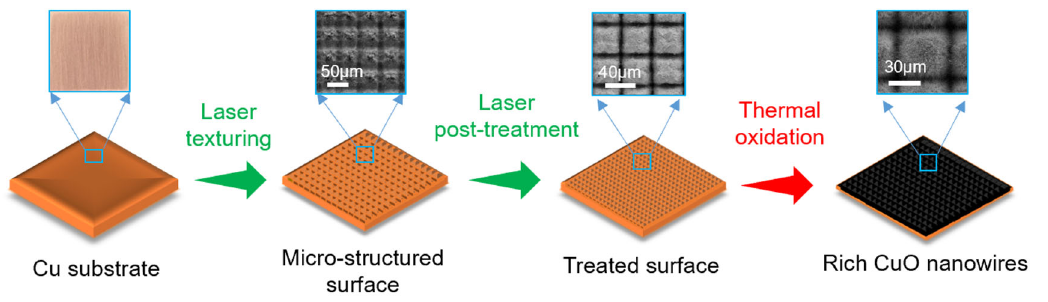
Figure 1. Schematic of rich CuO nanowire fabrication via laser texturing, laser post-treatment, and thermal oxidation (LT–LPT–TO).